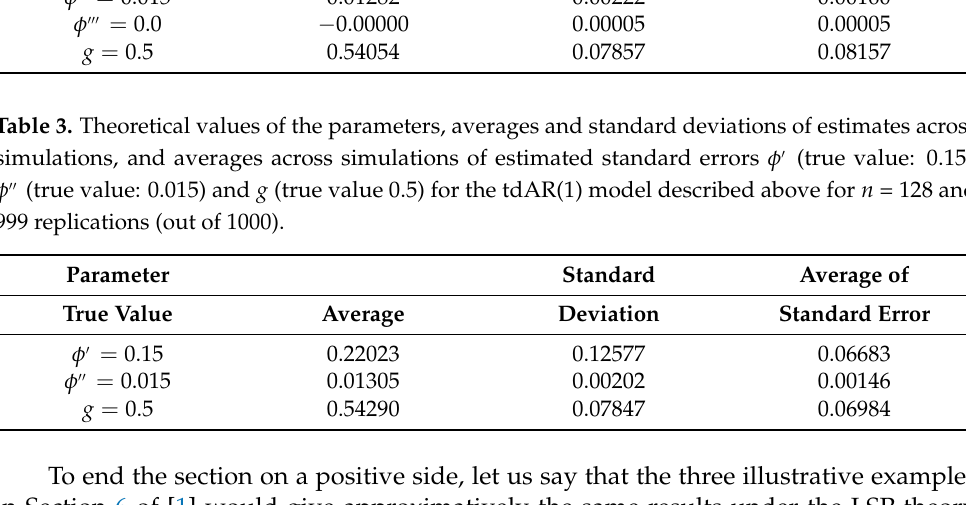
Table 2. Theoretical values of the parameters, averages and standard deviations of the estimates across simulations and medians across simulations of the estimated standard errors φ (cid:48) (true value: 0.15), φ (cid:48)(cid:48) (true value: 0.015), φ (cid:48)(cid:48)(cid:48) (true value: 0) and g (true value 0.5) for the tdAR(1) model described above for n = 128 and 964 replications (out of 1000). Parameter Standard Median of True Value Average Deviation Standard Error φ (cid:48) = 0.15 0.23554 0.14611 0.10380